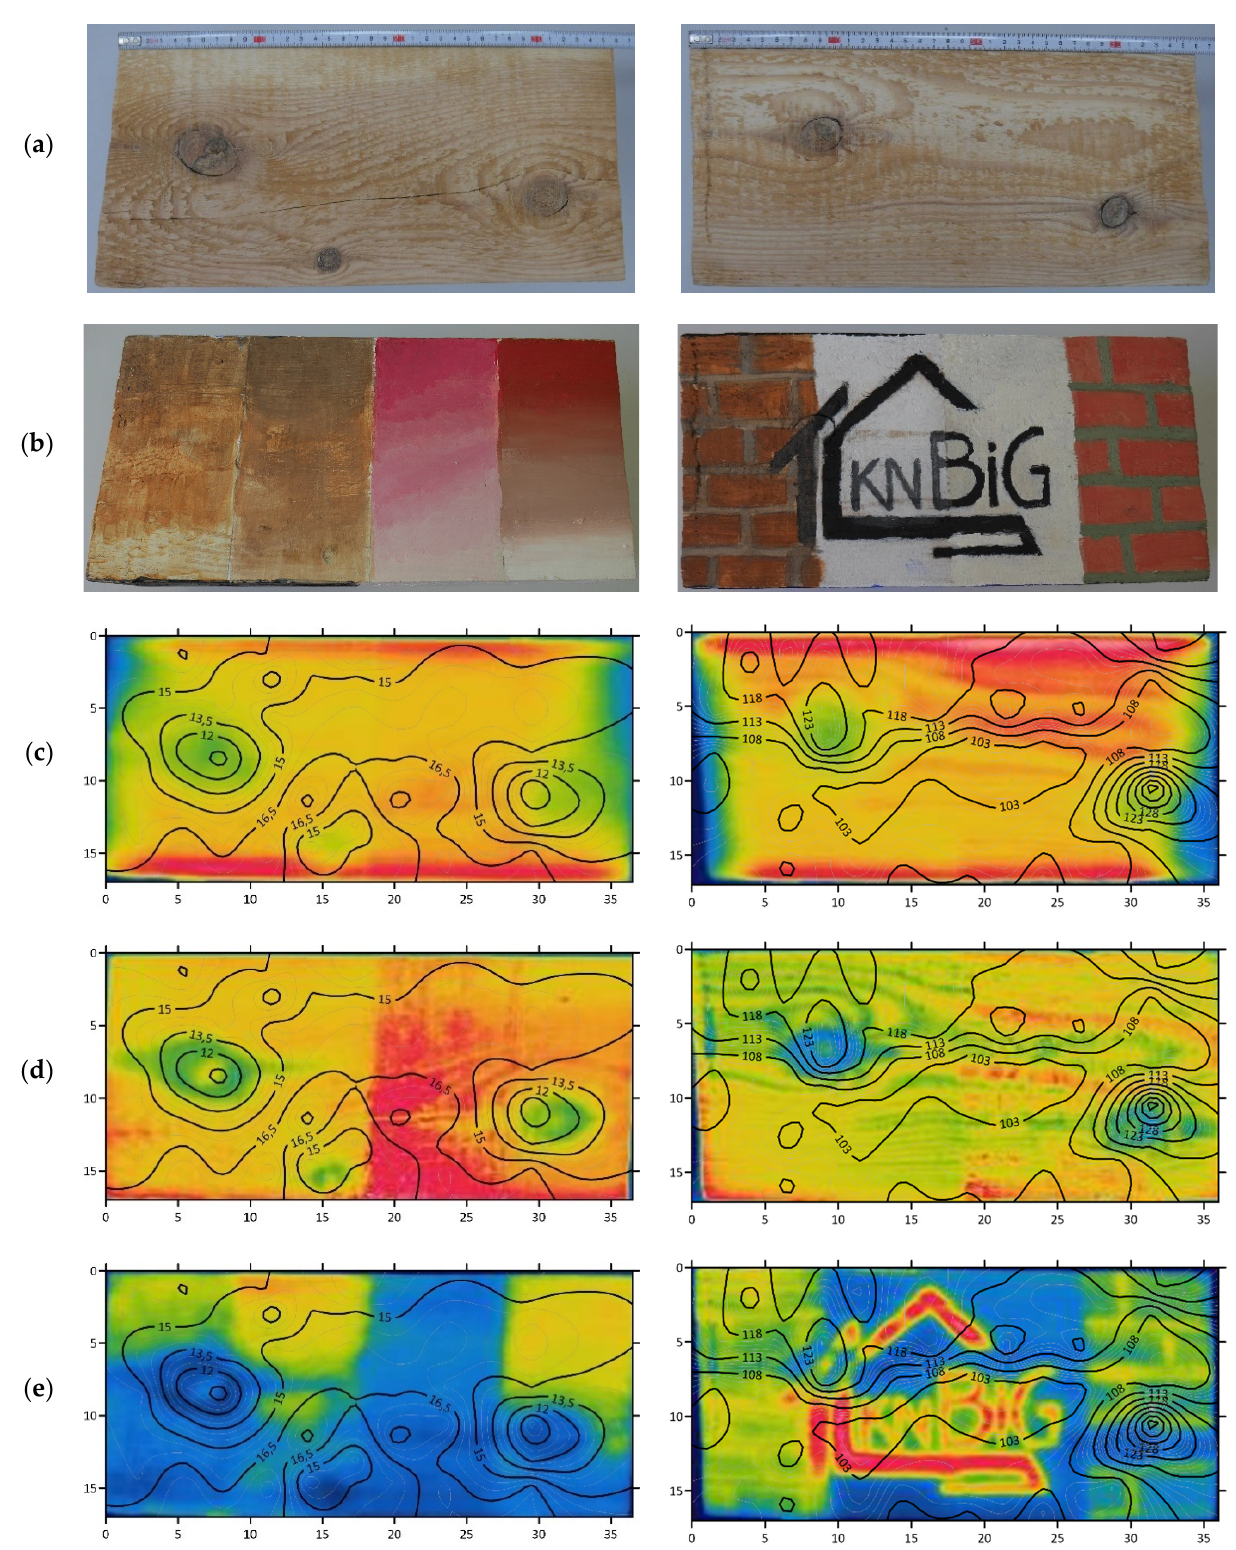
Figure 11. A comparison of the semi-destructive tests (SDTs) and thermographic tests (left—surface B and right—surface D): ( a ) surfaces before painting, ( b ) surfaces with paint coatings, ( c ) SDT results compared to thermal images of surfaces after preheating in laboratory dryer, ( d ) SDT results compared to thermal images during air heating and ( e ) SDT results compared to thermal during heating with halogen lamps.